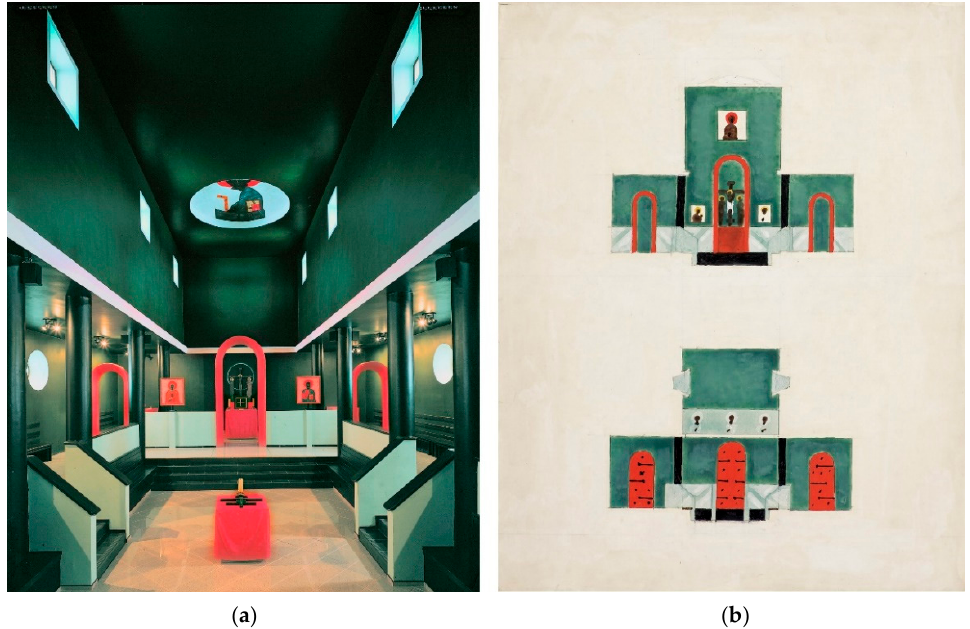
Figure 15. Church in Bia ł y Bór. ( a ) Overall view of the interior. Photography by Wojciech Kry ń ski. ( b ) Jerzy Nowosielski, color scheme of the interior. Photography by M. Gardulski/Galeria Starmach. Reproduced with permission.